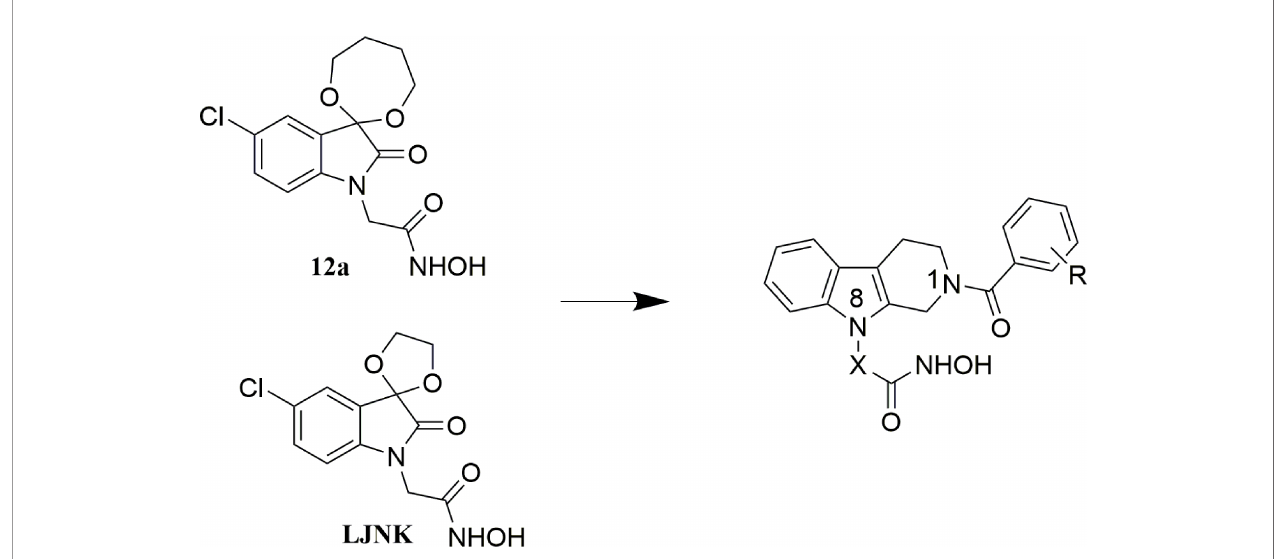
FIGURE 1 | Design of tetrahydro- b -carboline containing APN inhibitors (X = -CH 2 -, -CH 2 C 6 H 4